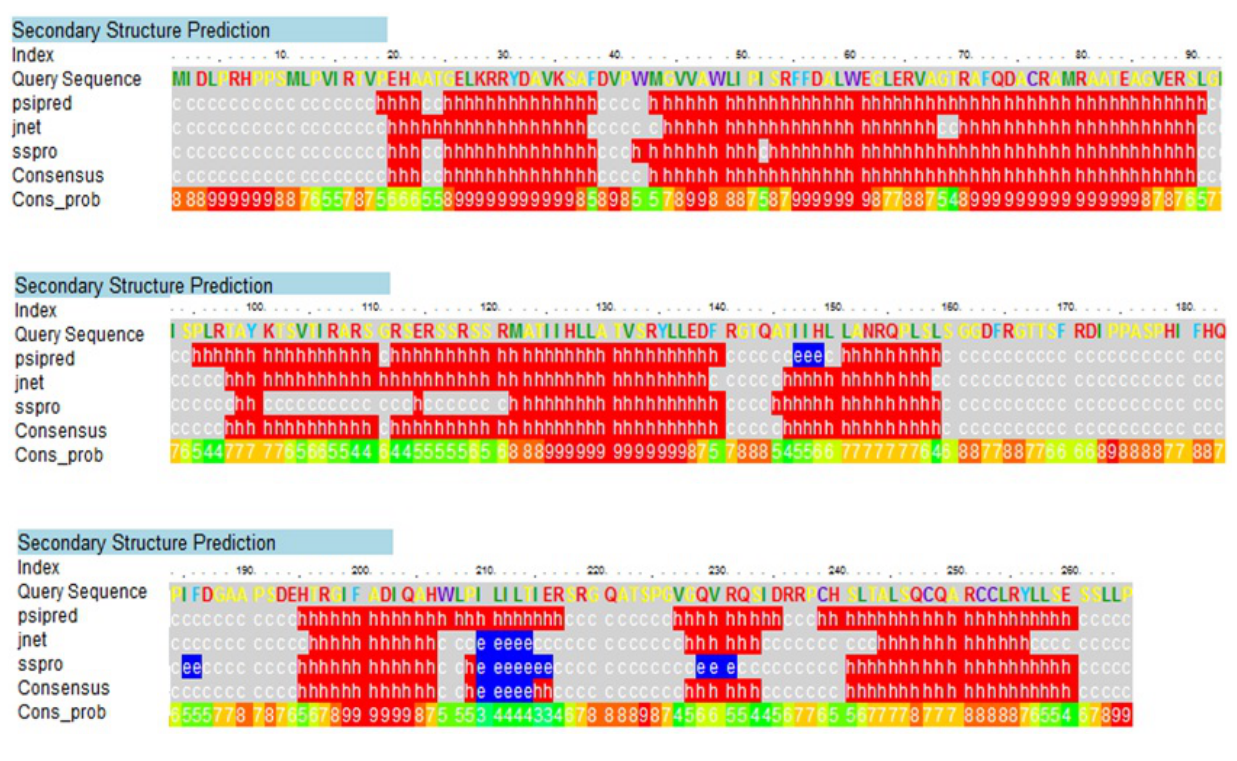
Figure 1. Secondary structural elements (SSEs) of DehD. Letters h stands for helix, c for coil and e for strand.